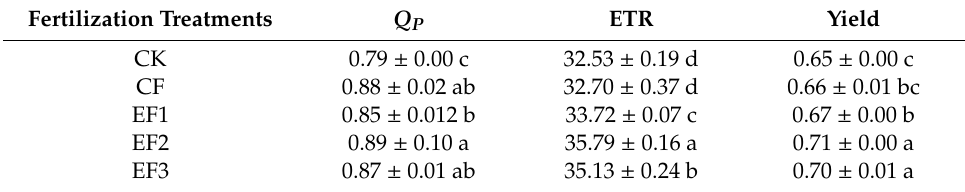
Table 2. Chlorophyll fluorescence of Chinese fir cuttings under di ff erent fertilization